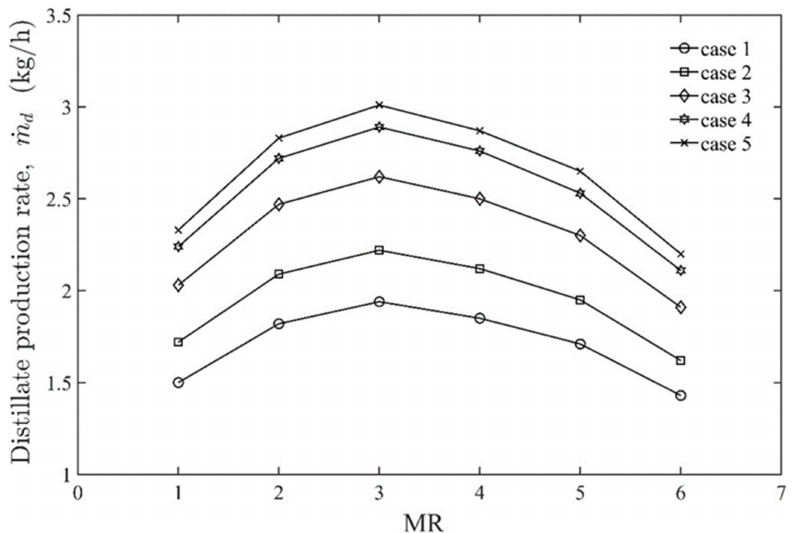
Figure 5. Distilled water flow rate variation with different MRs for all cases of CDI brine.